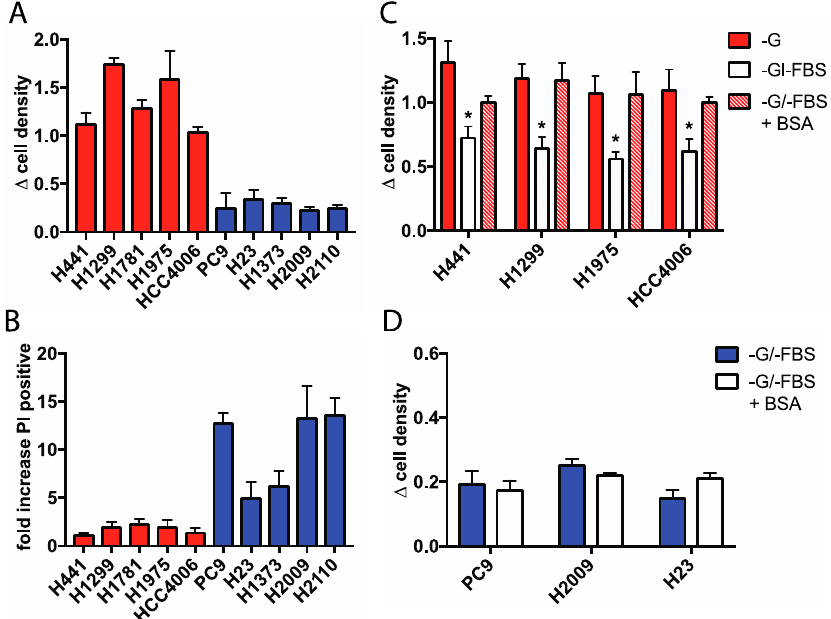
Figure 1. ( A ) Glucose independent (red) and glucose addicted (blue) NSCLC cell lines were cultured in glucose-free media (GFM) for 48 h. For all experiments, “change in cell density” is calculated by measuring the change in crystal violet staining from 0 to 48 h. Error bars indicate ± SEM of at least three experiments. ( B ) Cell death of NSCLC cells cultured in GFM for 24 h as measured by propidium iodide (PI) uptake. Values shown are the fold increase in PI positive cells in glucose-free media compared to cells cultured in full-glucose medium. Error bars indicate ± SEM of three independent experiments. ( C ) Change in cell density of glucose independent cells cultured for 48 h in GFM with or without dialyzed FBS (dFBS) or 2% albumin (BSA), “G”, glucose. Error bars indicate ± SEM of three independent experiments. Significance was calculated using ANOVA with Holm-Sidak multiple comparisons to –G condition, * p < 0.05. ( D ) Change in cell density of glucose addicted cells cultured in GFM alone or supplemented with 2% albumin for 48 h. Error bars indicate ± SEM of at least two independent experiments.